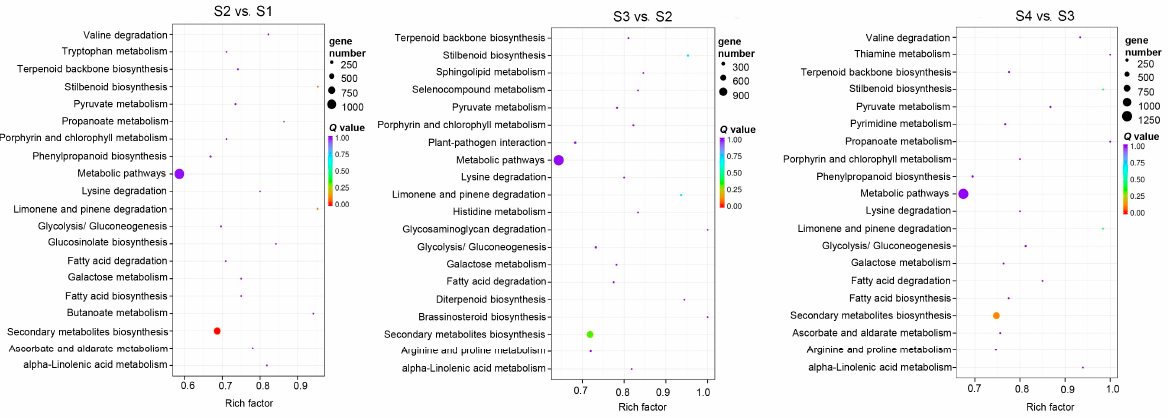
Figure 4. KEGG enrichment pathway analysis of DELs in S2 vs. S1, S3 vs. S2, and S4 vs. S3. The top 20 KEGG pathways of the DELs are displayed.